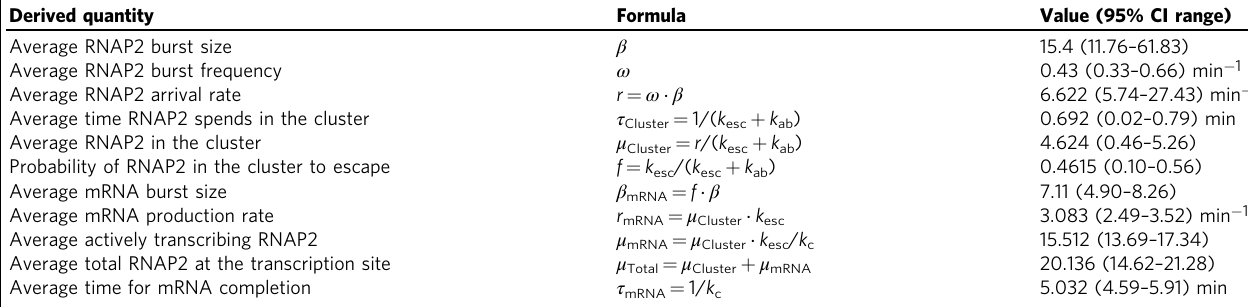
Table 1 Derived quantities and con fi dence intervals resulting from the model fi t to data. Derived